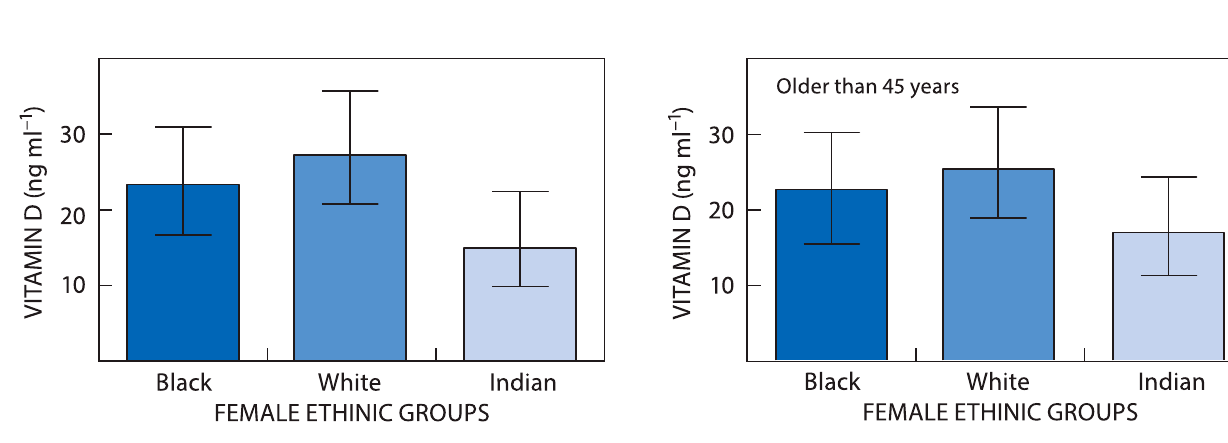
Figure 1: 25(OH)D level and ethnicity of study participants. Figure 4: 25(OH)D levels among > 45 year-olds.